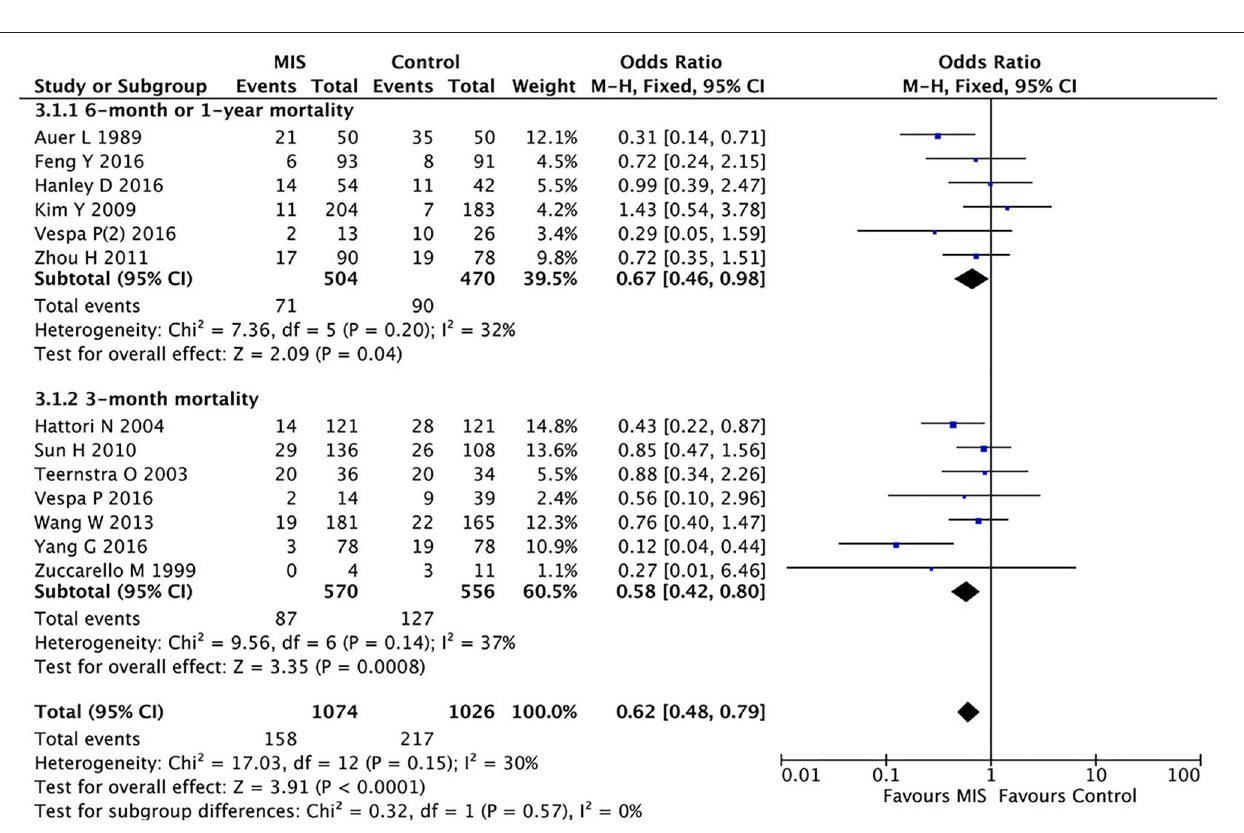
FIGURE 3 | A forest plot of the subgroup analysis of the minimally invasive surgery and control groups for long-term (6-month or 1-year) and short-term (3-month) mortality.